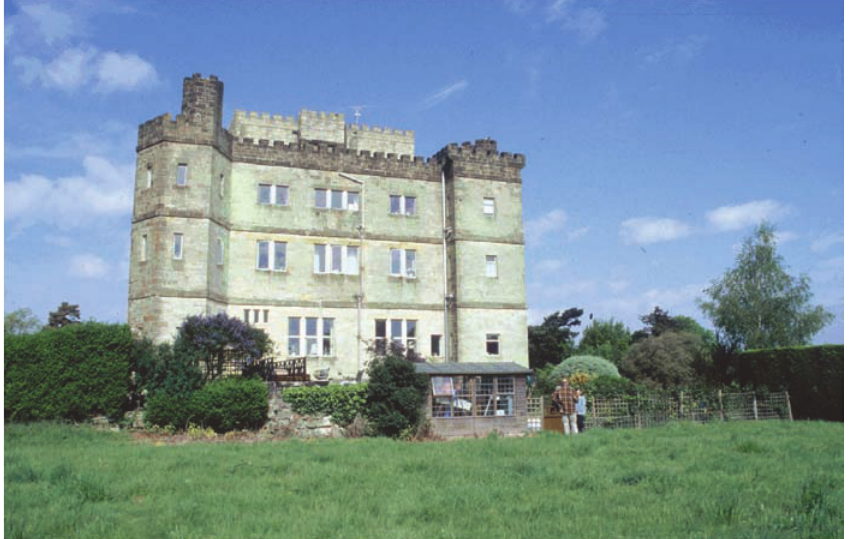
Figure 2 “Harley’s Castle”, the monumental house of Beedings, built at the turn of the 20th